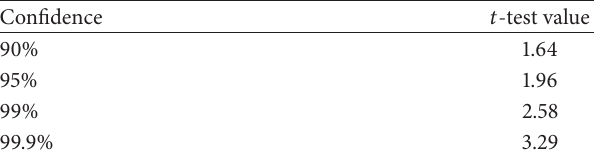
Table 4: Confidence interval based on 𝑡